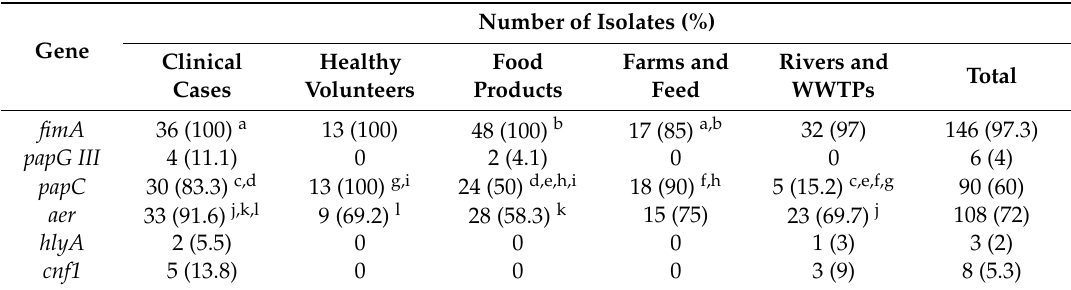
Table 2. Prevalence of virulence-associated genes among extended spectrum β -lactamase (ESBL)- producing E. coli from different sources .